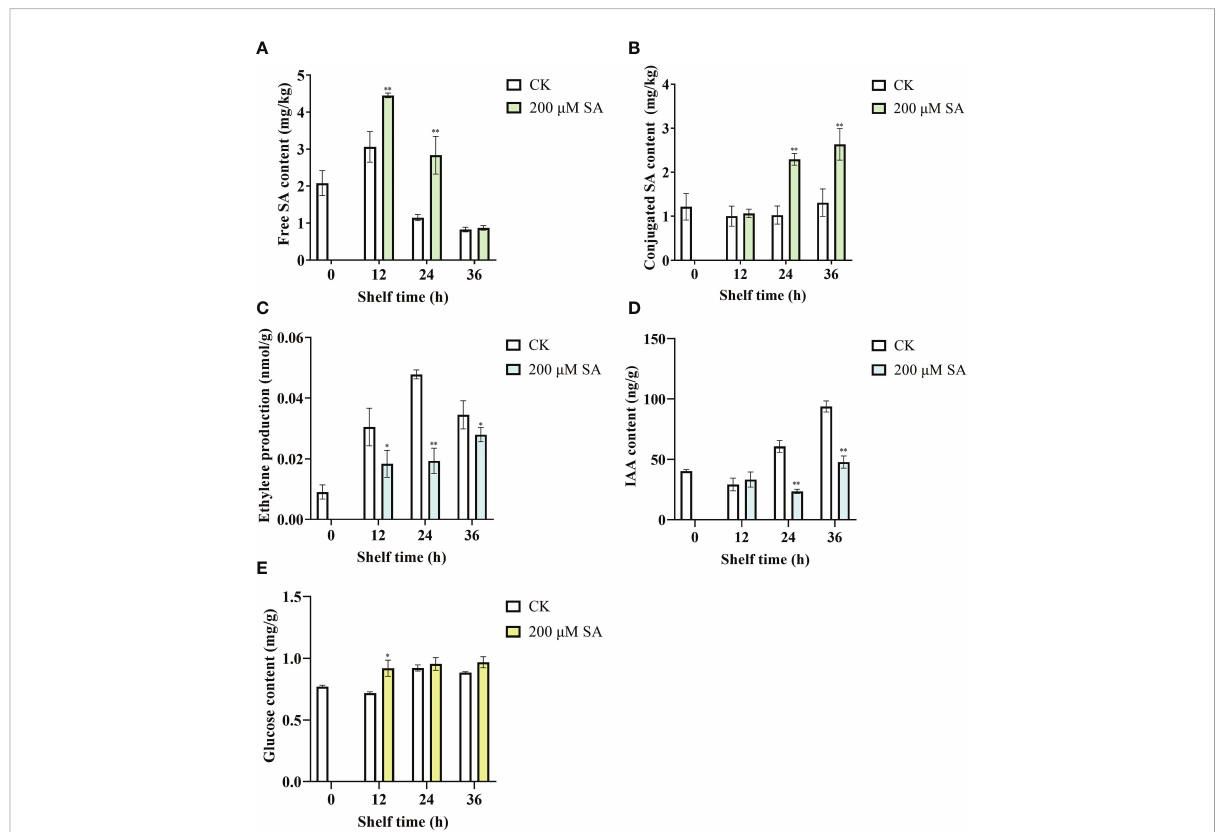
FIGURE 6 Free SA (A) , conjugated SA (B) , ethylene production (C) , IAA (D) , and Glucose (E) in pear fruit after SA treatment at room temperature. The mean values and standard errors (bar) from three independent experiments are shown. Independent t tests for equality of means demonstrated